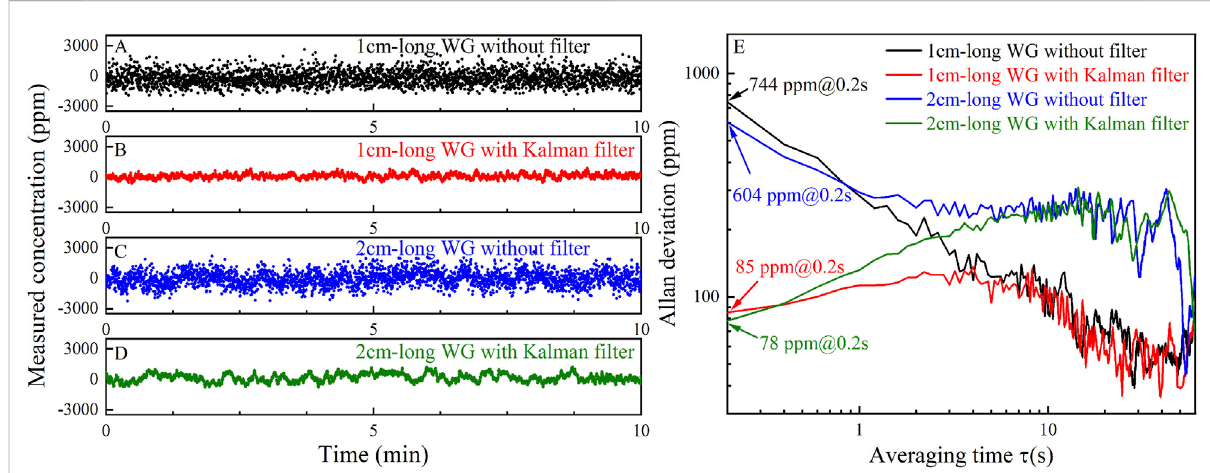
FIGURE 9 Measured CH 4 concentration levels in N 2 environment using the 1 cm-long waveguide (A) without Kalman fi lter and (B) with Kalman fi lter. Measured